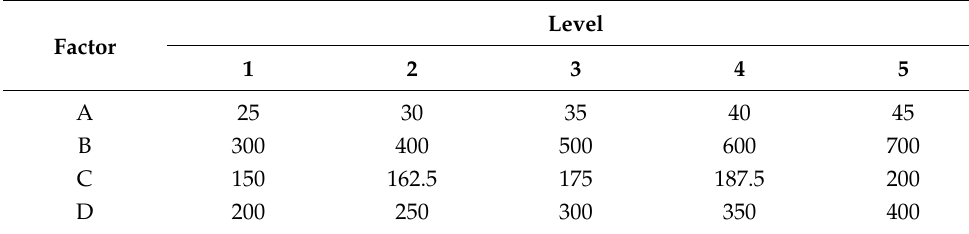
Table 3. Factor levels in single-factor tests.